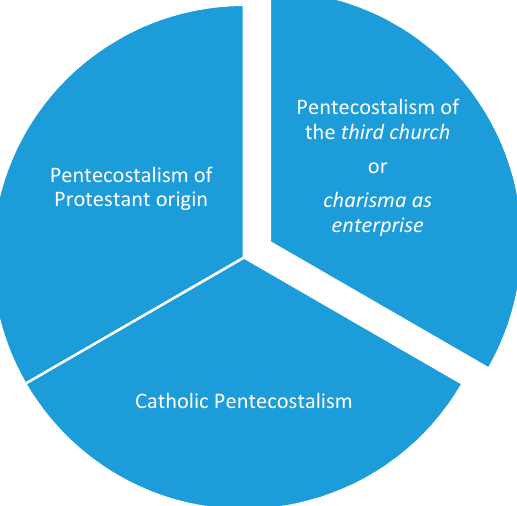
Figure 4. The di ff erences within the Pentecostal religious Figure 4. The differences within the Pentecostal religious camp.